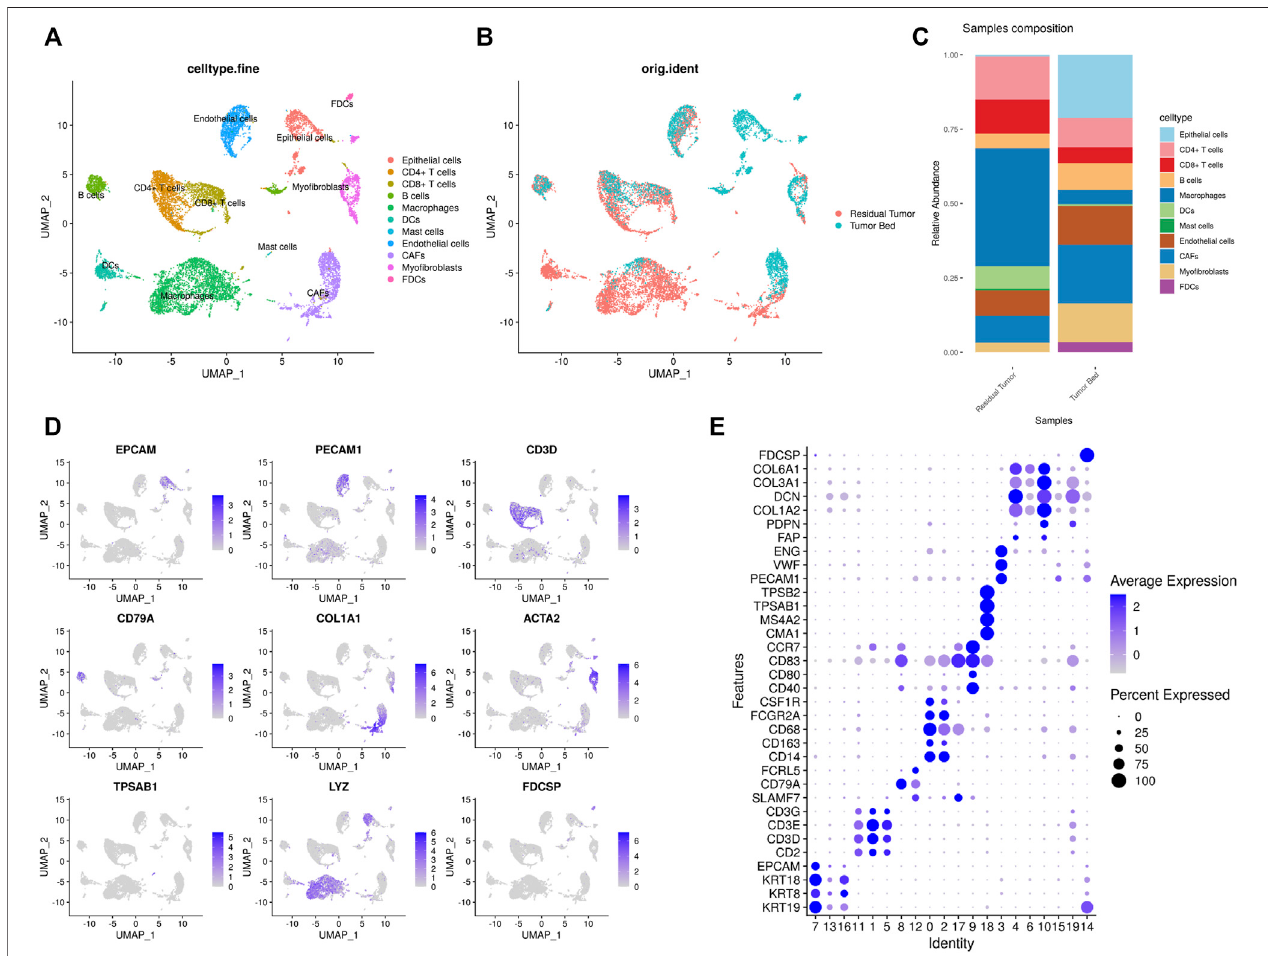
FIGURE 2 | Single-cell transcriptomic map of OSCC after ICT (A,B) . (A) UMAP plot presentation of OSCC grouped by annotated cell types. (B) UMAP plot of originalident(fromresidual tumor ortumor bed). (C) Thecompositionofcelltypes shown inresidual tumor sampleand tumor bed sample. (D) Theexpression ofmarker genes shown in feature plots. (E) Dot plots showing the maker genes of each cluster of OSCC.